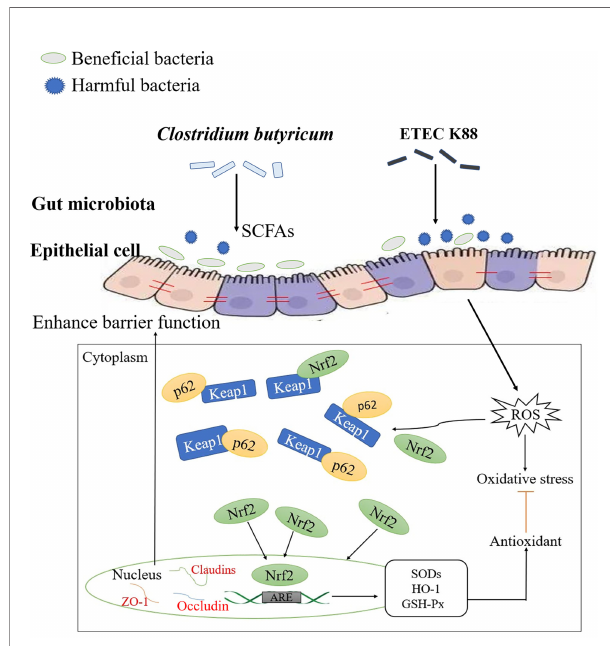
FIGURE 10 | Diagram outlining the mechanism of CB on alleviating ETEC K88-induced oxidative